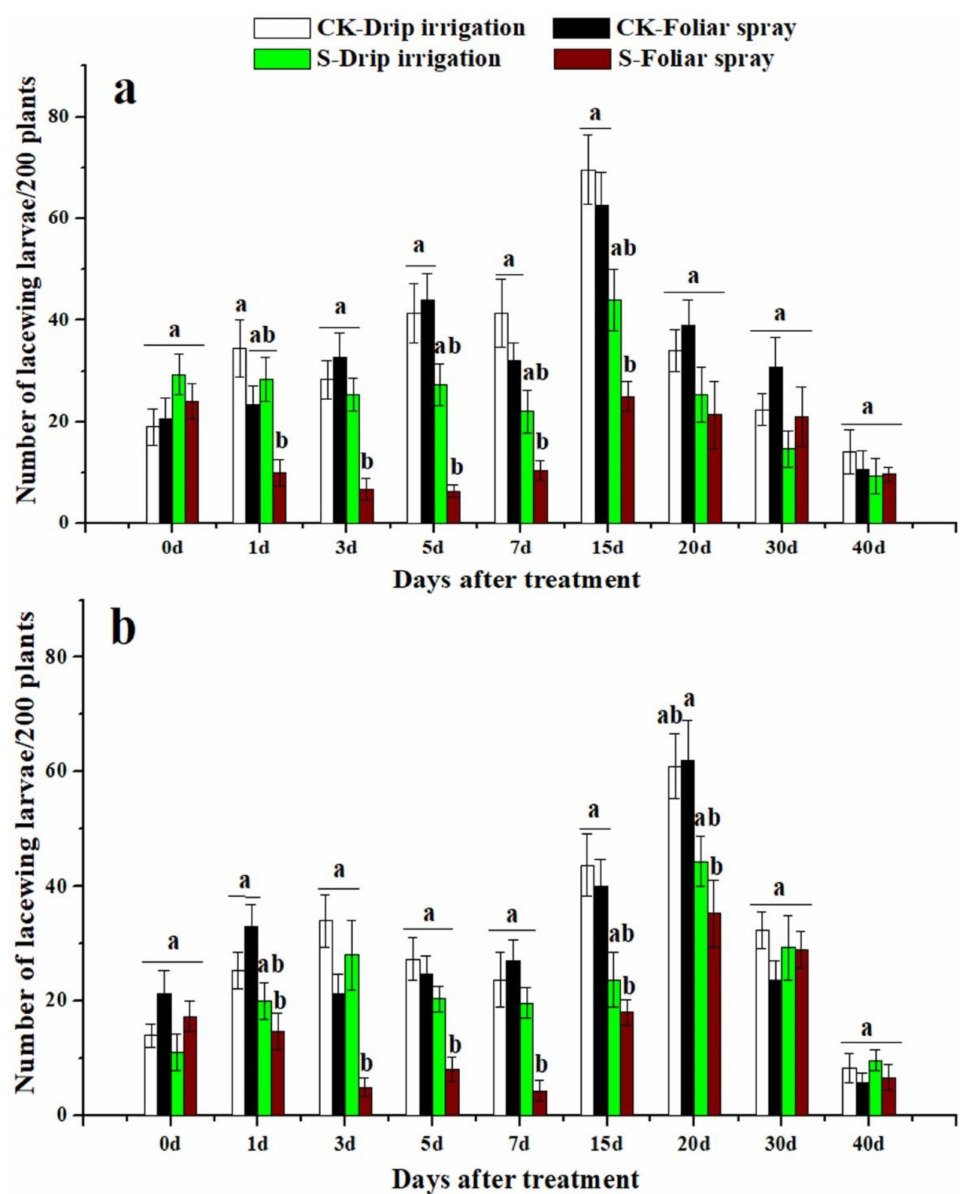
Figure 6. The numbers of lacewing larvae on cotton plants not treated with any chemical (CK-Drip irrigation and CK-Foliar spray) and treated with sulfoxaflor through drip irrigation (S-Drip irrigation) and foliar spray (S-Foliar spray) in 2016 ( a ) and 2017 ( b ). All data are expressed as mean ± S.E. (n = 3). Values within the same time period labeled with di ff erent letters are significantly di ff erent based on Tukey’s HSD test at p <